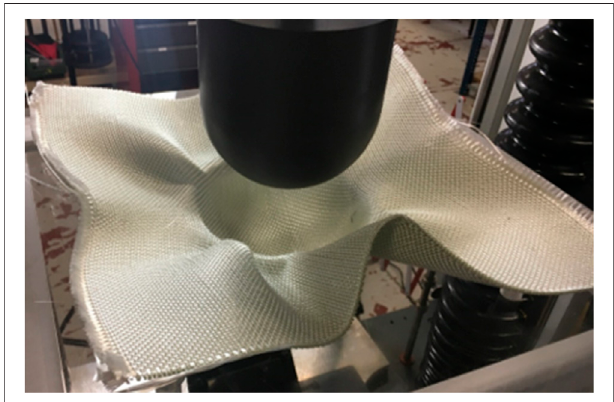
FIGURE 1 | A punch release after hemispherical forming of a textile reinforcement based on glass fi bers.